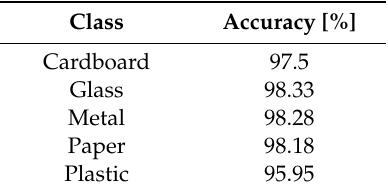
Table 4. Best model evaluation for our TrashNet